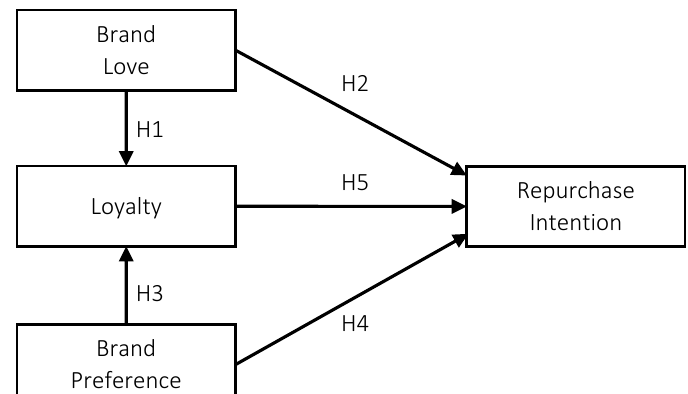
Figure 1. Theoretical